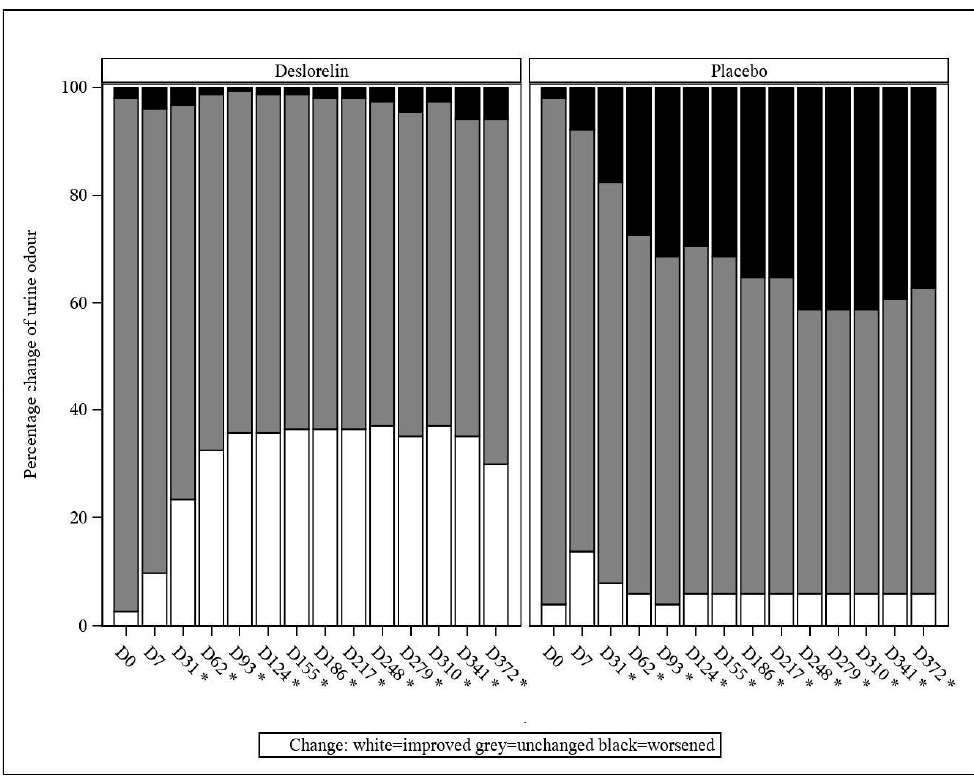
Figure 4. Intact male cat urine odor percentage change compared to baseline. * Significant difference ( p < 0.001) between groups from D31 onwards.